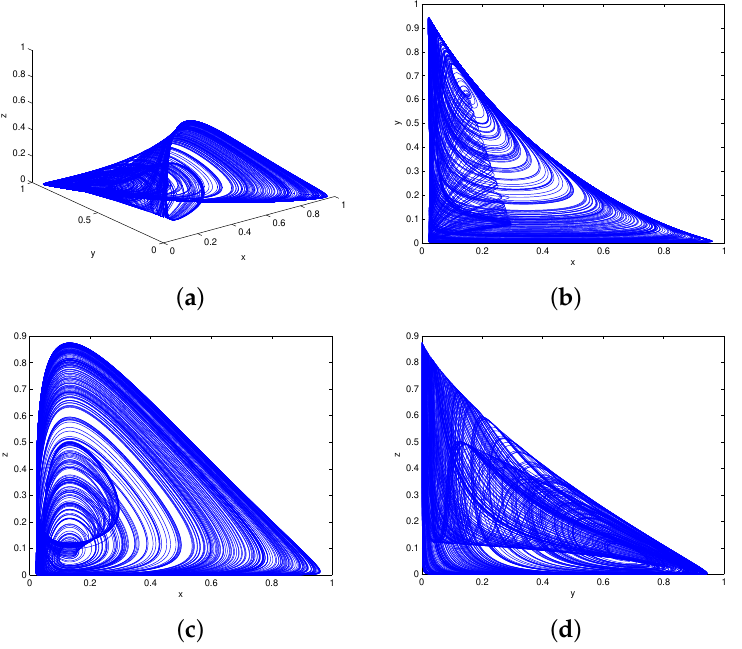
Figure 10. ( a ) Strange attractor of system (8) with Runge-Kutta fourth order method and h = 0.1. ( b – d ) Projection of the attractor to system (8) onto the planes by each variable, x , y , and z . ( a ) Strange attractor; ( b ) host cells: X = x ; ( c ) immune effector cells: X = y ; ( d ) tumor cells: X = z